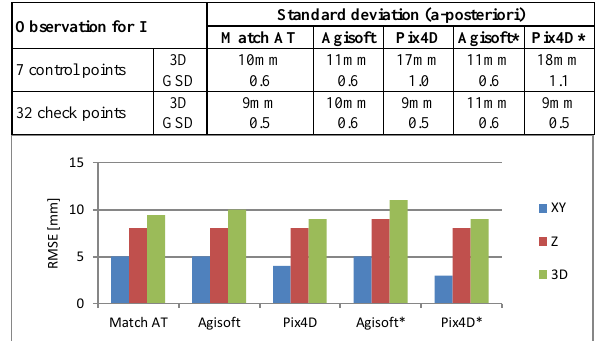
Figure 12: RMSE results at 32 check points (configuration I)